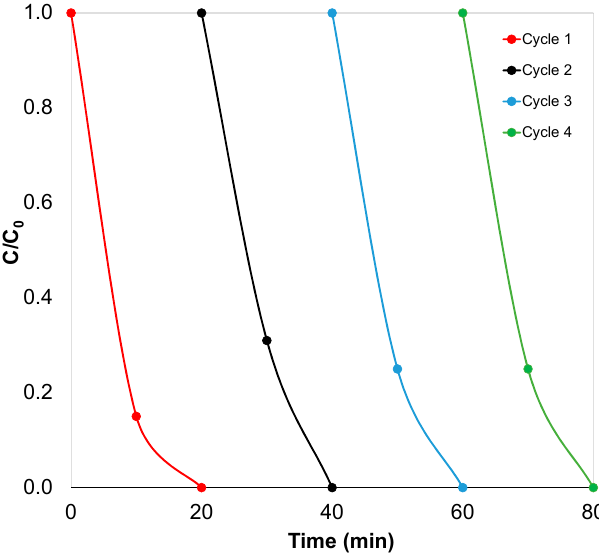
Figure 9. Removal of SMX for four consecutive runs. Experimental conditions: C SMX = 500 μ g/L; C LNO = 250 mg/L; C SPS = 100 mg/L; pH = 6; room temperature.